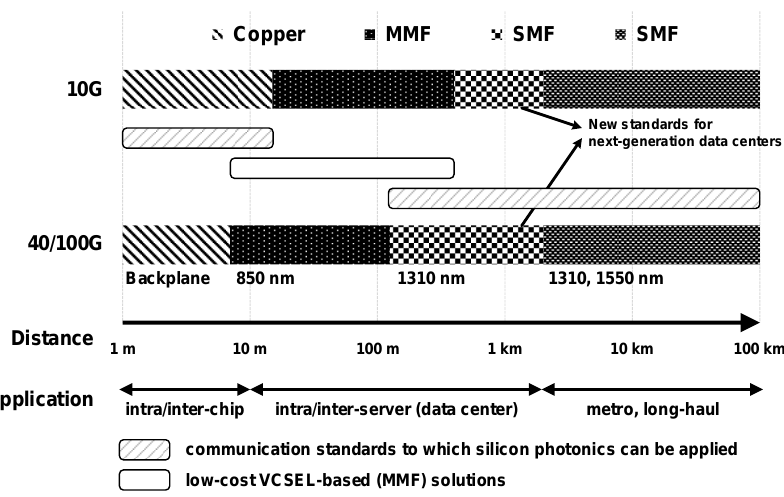
Figure 5. Summary of communication standards, Ethernet.